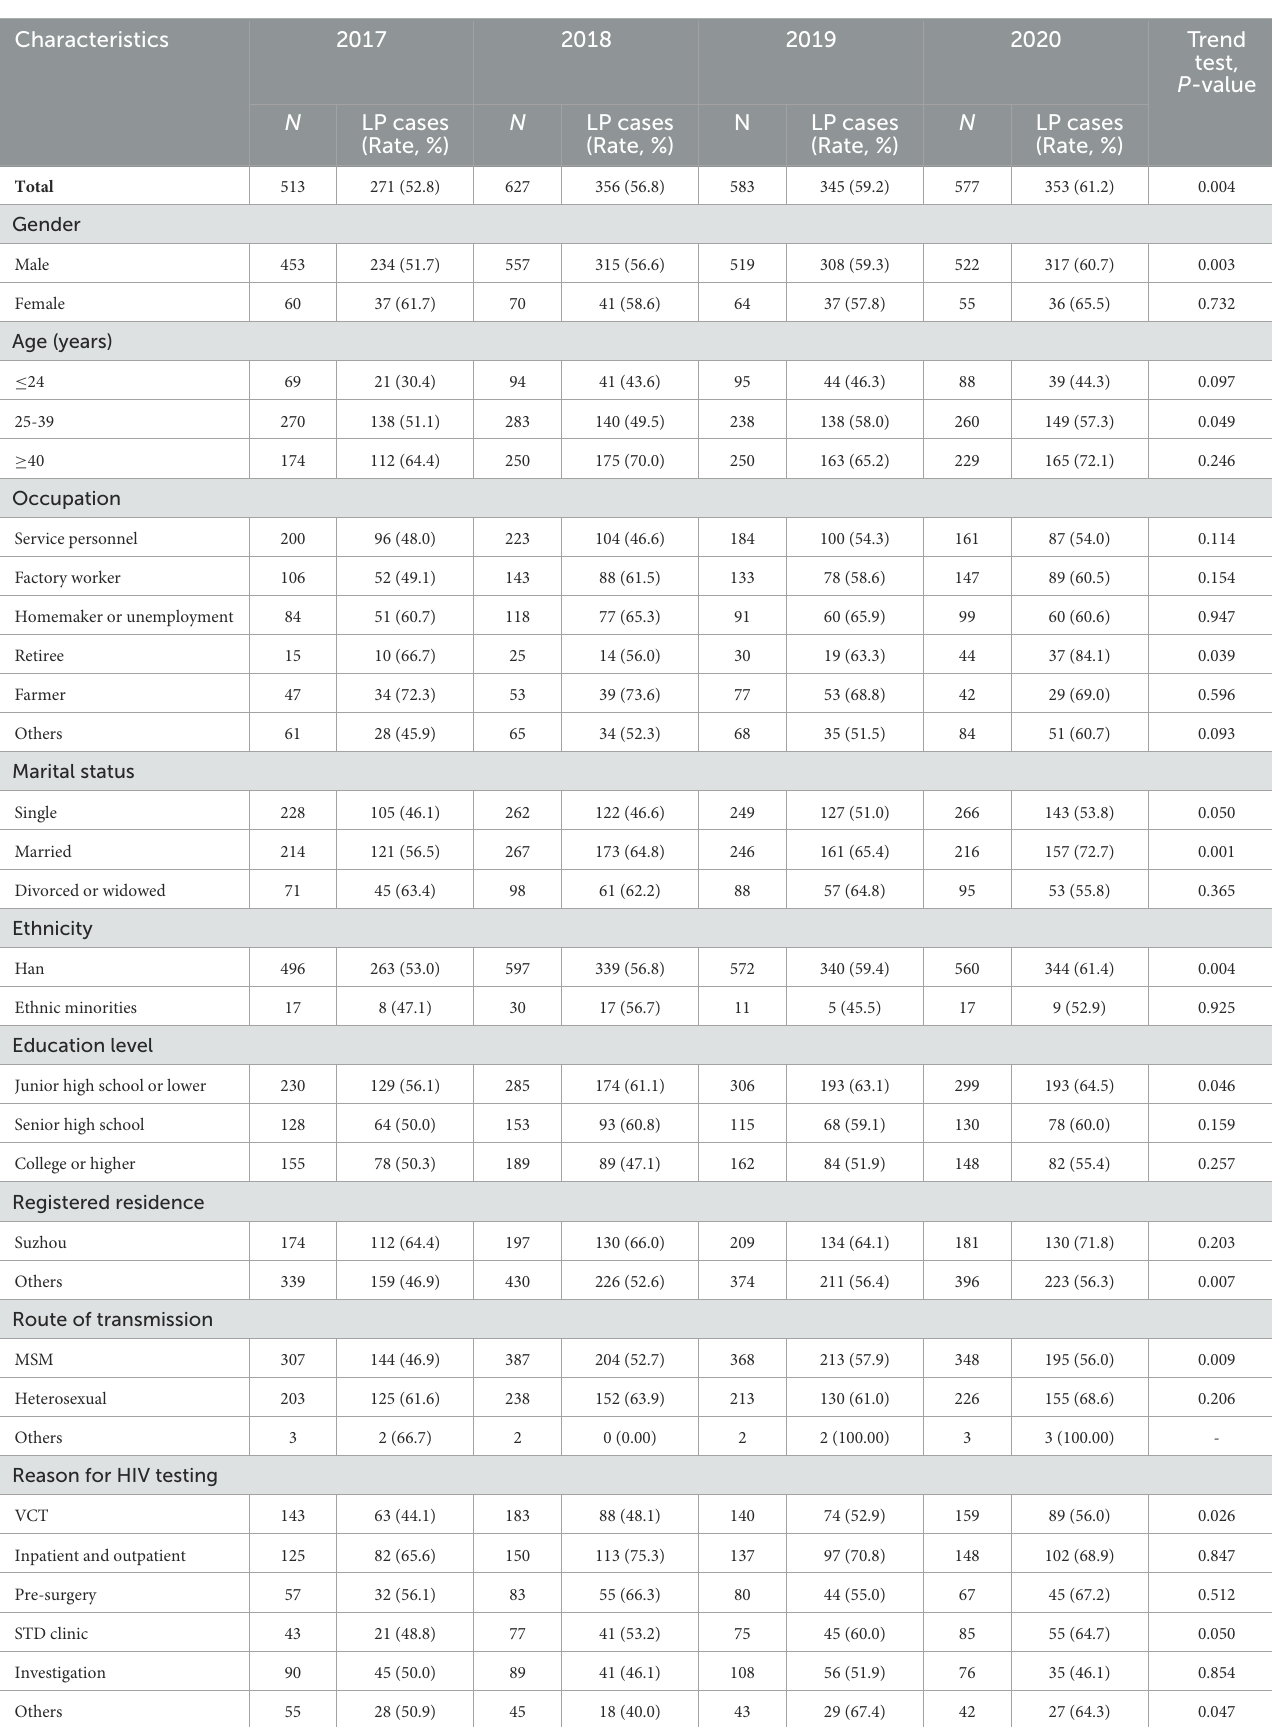
TABLE 2 Trends in late presentation of HIV infection among patients with newly diagnosed